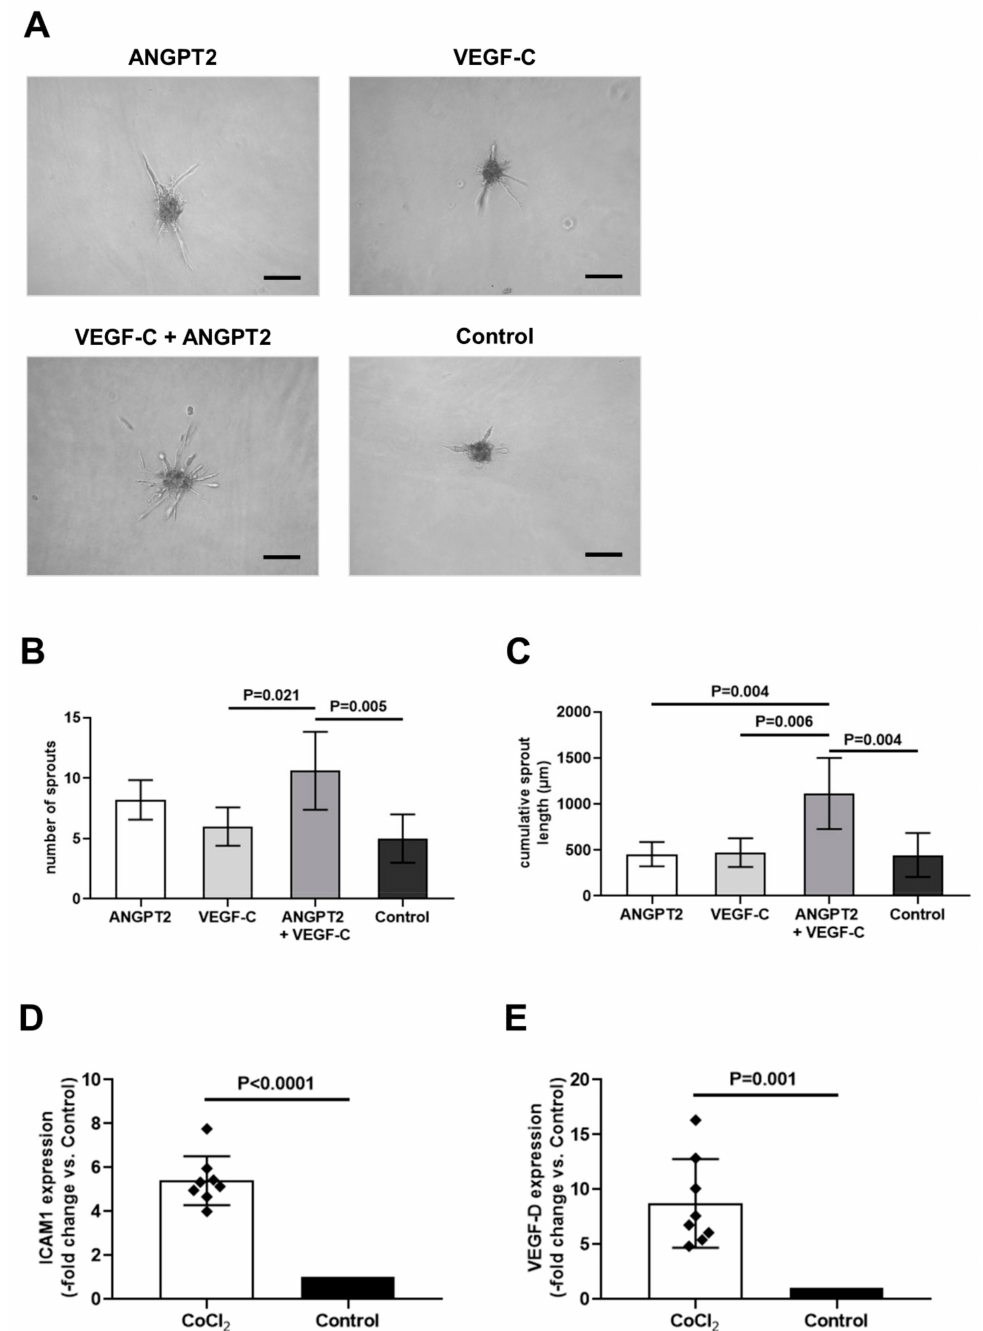
Figure 6. E ff ects of ANGPT2 and VEGF-C on human sprouting lymphangiogenesis. Representative images of human dermal lymphatic endothelial cell (HDLEC) spheroids ( A ) as well as the results after quantitative analysis of the number of sprouts (per spheroid) ( B ) and the cumulative sprout length ( µ m) in n = 5 spheroids ( C ) after stimulation with recombinant human ANGPT2; (100 ng / mL) and / or VEGF-C (100 ng / mL) or control (CTL). Size bars represent 200 µ m. ( D–E ) Quantification of mRNA expression of ICAM1 ( D ) and VEGF-D ( E ) in HDLECs, after induction of chemical hypoxia using 1 mM of CoCl 2 for 4 h in n = 8 independent experiments. Bars represent fold change of mean mRNA expression compared to Control. Error bars represent standard deviation. Statistical analysis was performed using one-way ANOVA with Turkey’s multiple comparisons test ( B , C ) and Student’s paired t -test ( D , E